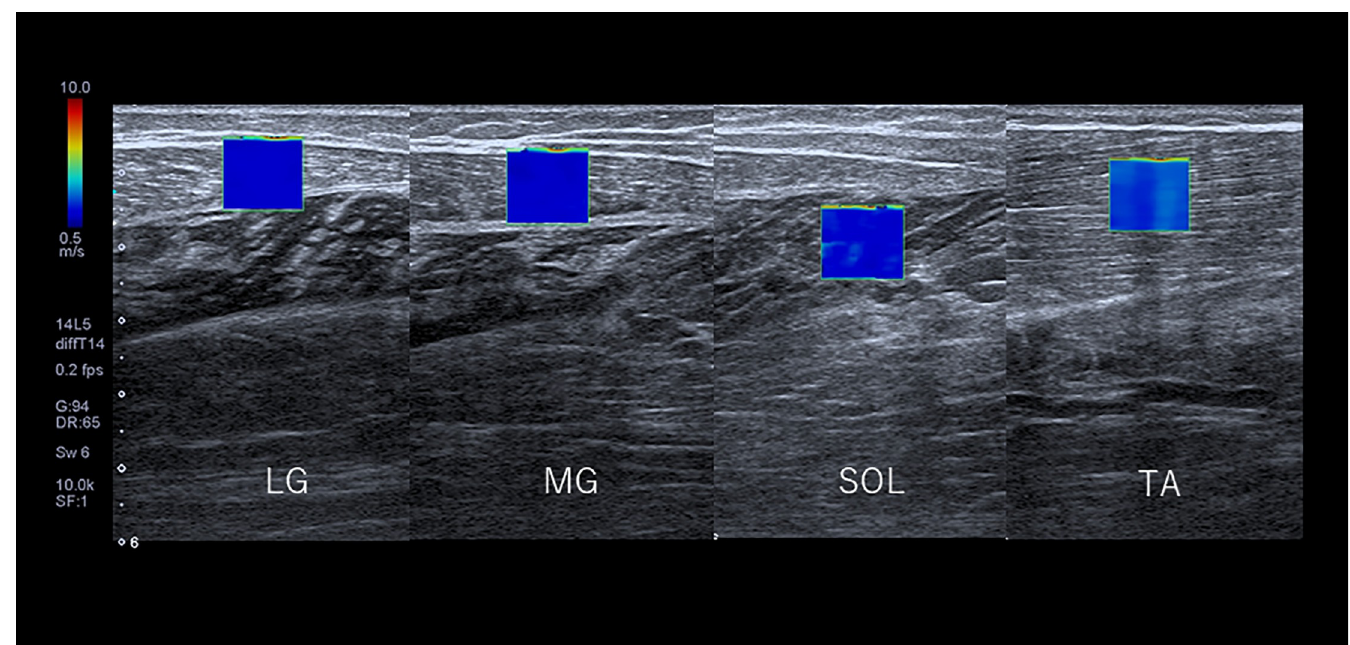
Fig 4. Image of shear wave elastography of lower leg muscles. LG: Lateral gastrocnemius, MG: Medial gastrocnemius, SOL: Soleus, TA: Tibialis anterior. ROI: Region of interest: 1 cm x 1 cm.